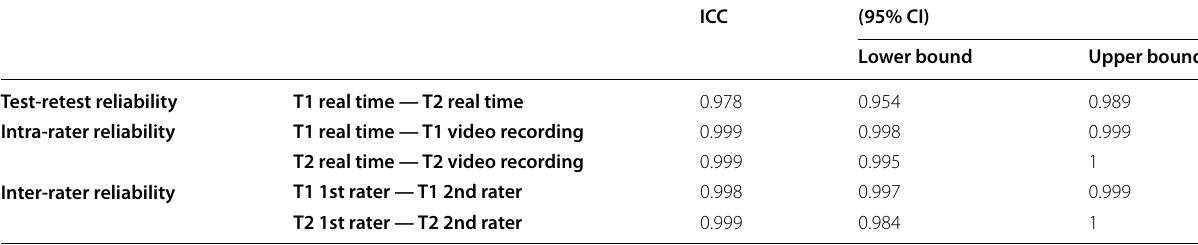
ICC intra-class correlation coefficient value, CI confidence